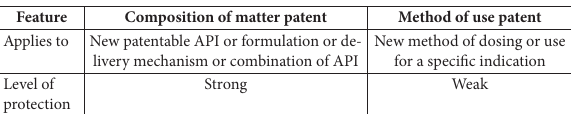
Table 1. Comparison between composition of matter patent and method of use patent.